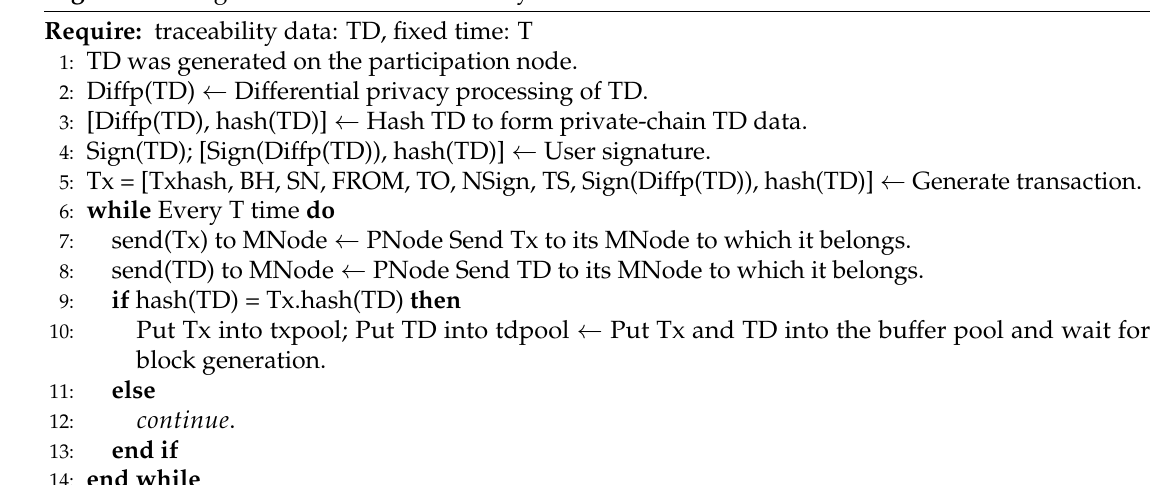
Algorithm 4 Algorithm for store traceability data.